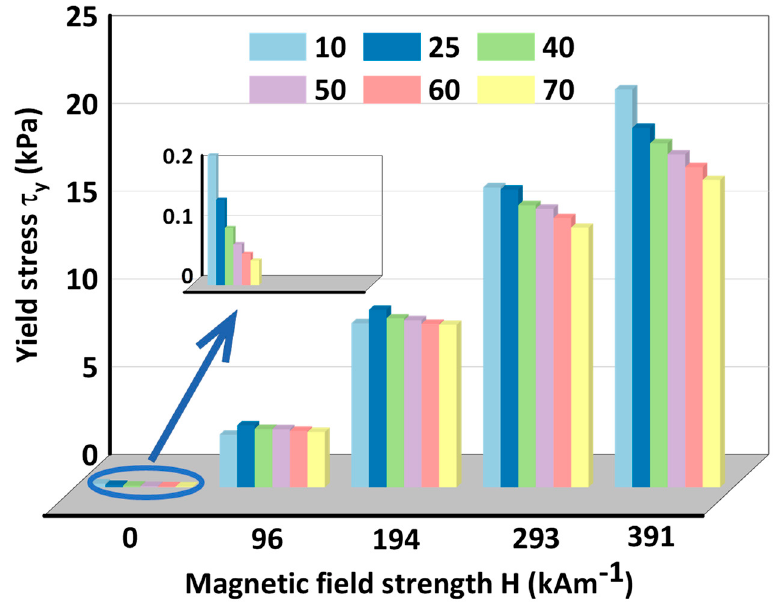
Figure 6. Maximum yield stress of MRG as a function of temperature under different magnetic field strengths.